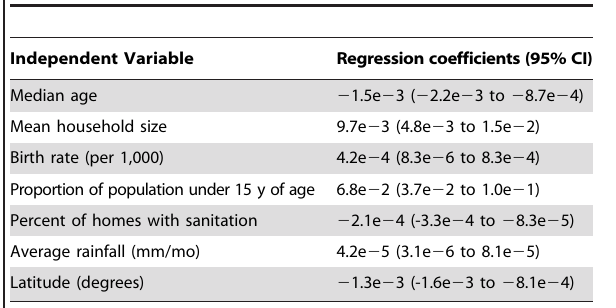
Table 1. Results of univariate linear regression of force of infection estimated using model 4 on demographic, socioeconomic, and climatic characteristics of provinces.